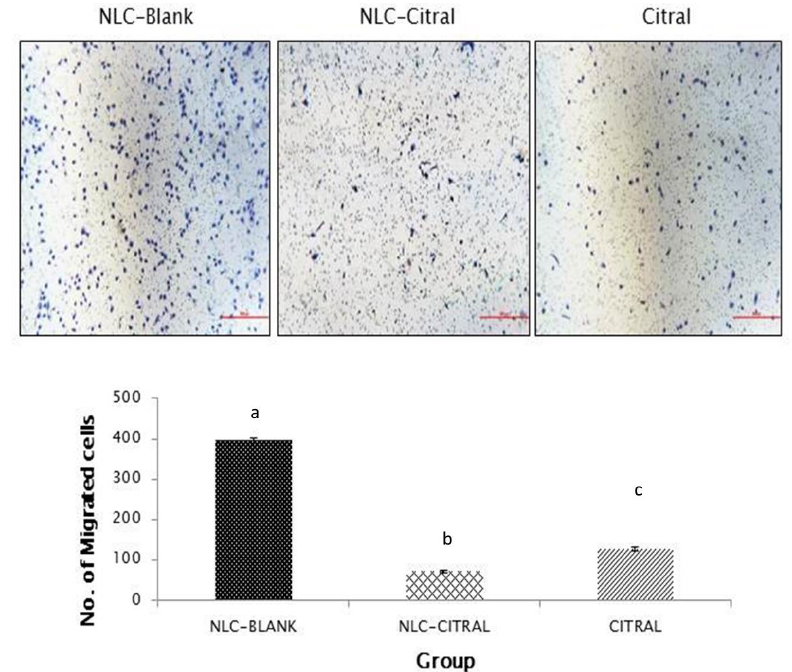
Figure 3. The representative images and bar chart analysis of migrated 4T1 cells through the transwell membrane after 24 h of treatment with 26 µg/mL (IC 40 ) of NLC-Citral, citral, and NLC-Blank. The number of migrated cells was counted based on the presence of the blue dye stained cells. The images were viewed at 200× magnification. Each value in the bar chart is represented as mean ± SD and the experiment was performed in triplicate. Significance indicated by different alphabet was set at p < 0.05 comparing between groups. The scale bars show 500 px (13.2 cm).